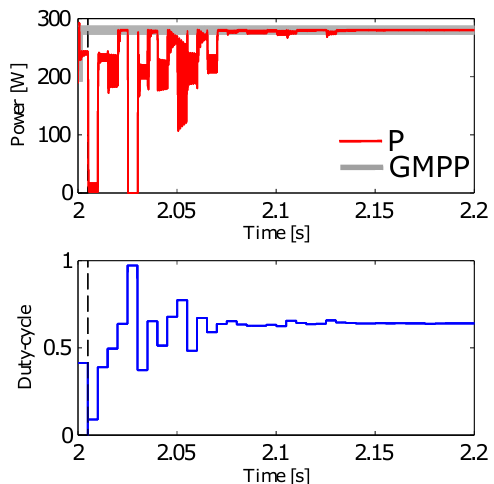
Figure 11. Characteristic chartering observed in PSO. The colors blue, red were used respectively for the instantaneous duty-cycle and power and the gray for the theoretical